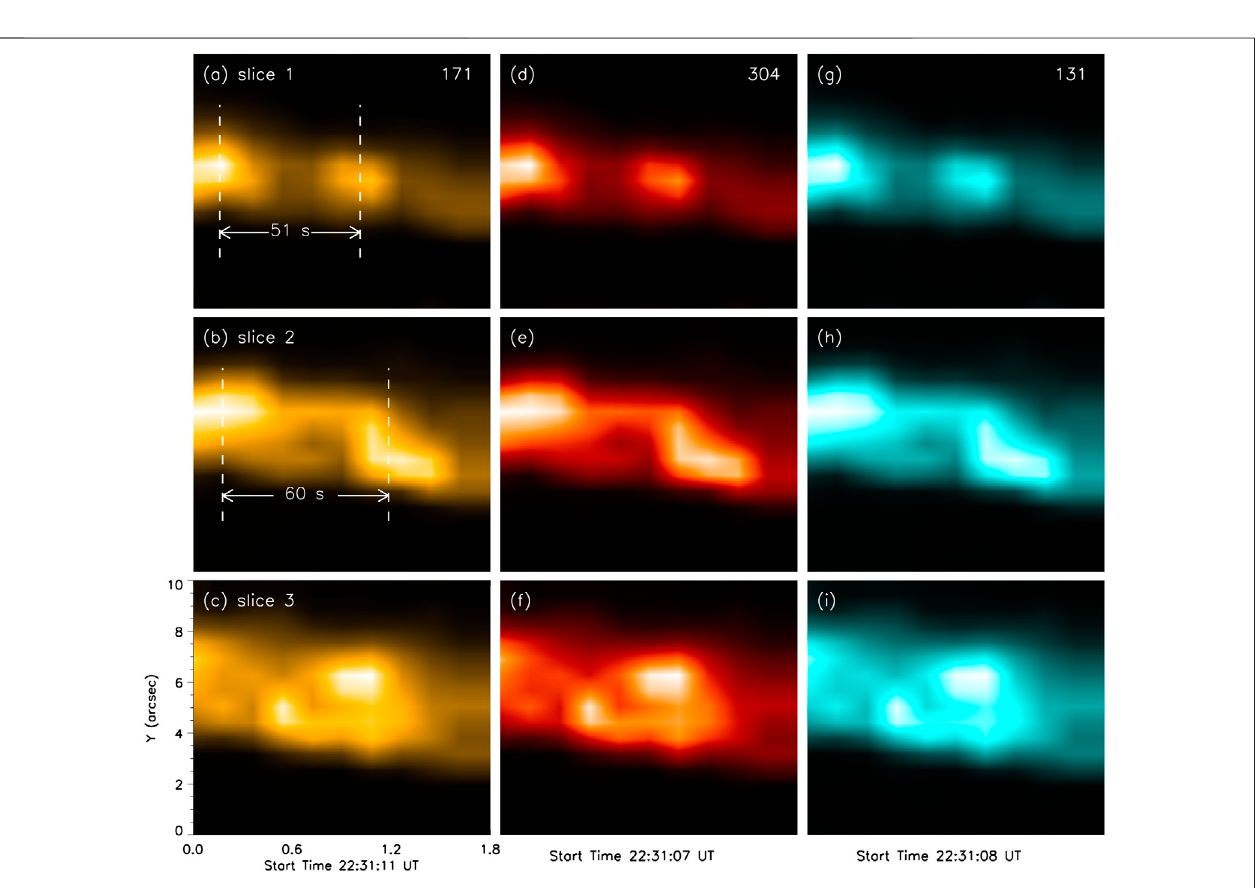
Frontiers in Astronomy and Space Sciences |